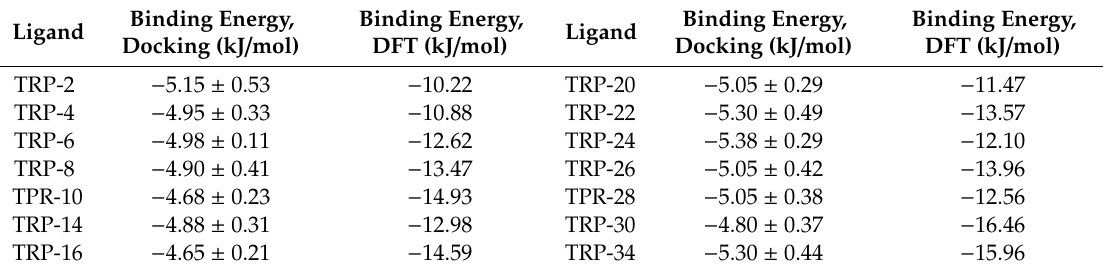
Table 5. The docking and DFT (density functional theory) results obtained with respect to the studied ligands. The docking calculations were averaged over four teicoplanin structures available in the PDB (Protein Data Bank) records; the corresponding standard deviations are